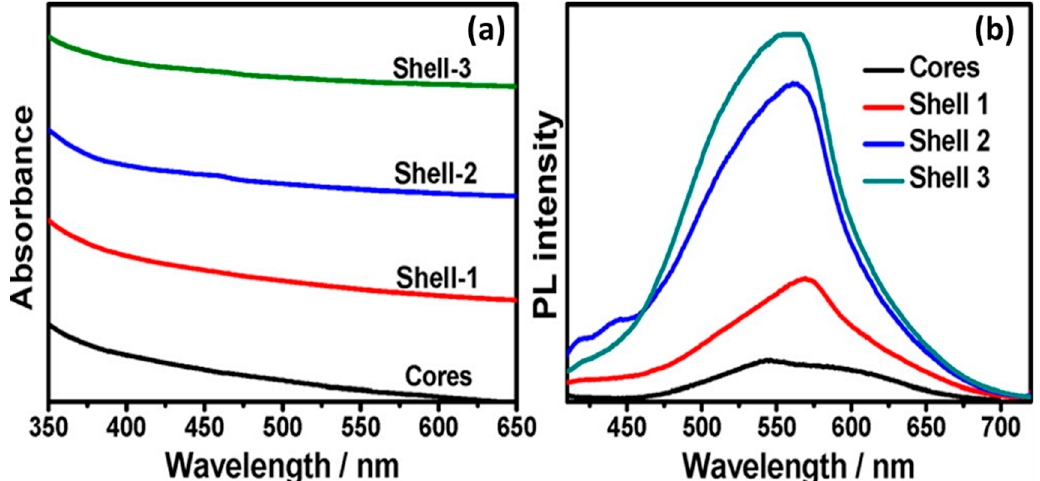
Figure 6. UV-vis absorption ( a ) and PL ( b ) spectra of Cu − In − S core QDs and Cu − In − S / ZnS core / shell QDs with deposition of di ff erent thicknesses of the ZnS shell around the core QDs that were synthesized in water